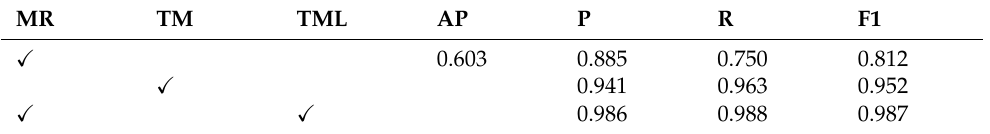
Table 1. Final Results of flood detection. MR means Mask RCNN model. TM means temporal model using only mean squared error (MSE) between drain tube region frames as input. TML means using both MSE between consecutive frames and the predicted bounding boxes confidence scores from Mask RCNN. P, R, and F1 stand for precision, recall, and f1 score, respectively.